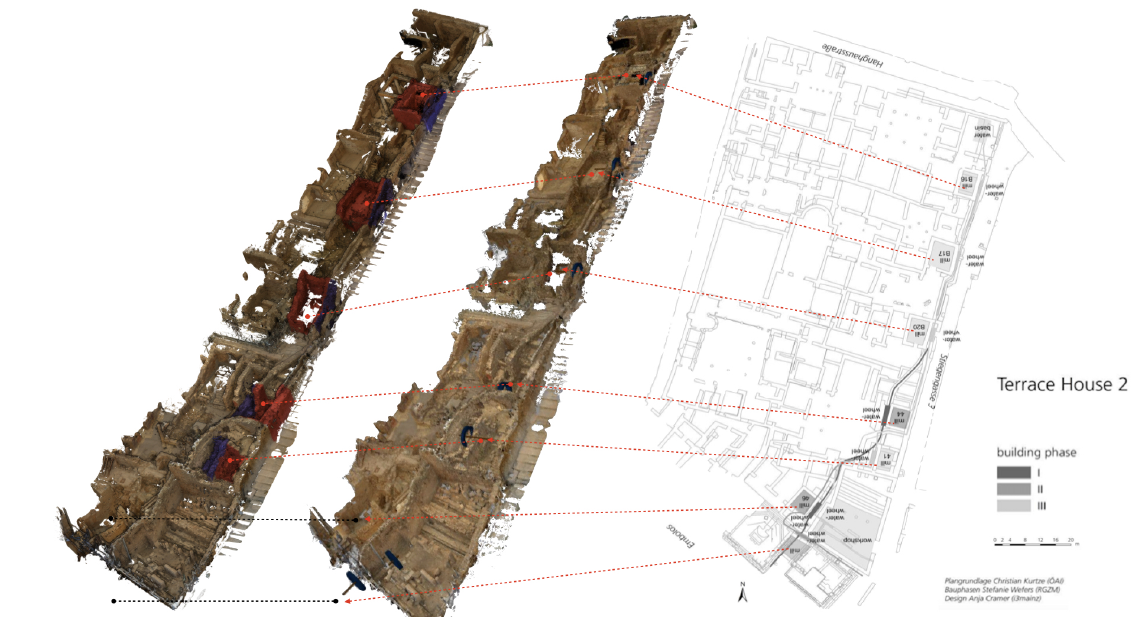
Figure 15. Watermill recognition in Ephesos terrace house 2: ( left ) point cloud with detected watermills in blue and red; ( middle ) watermills with their water wheel [50]; ( right ) terrace house 2 plan presenting watermills and their construction phases